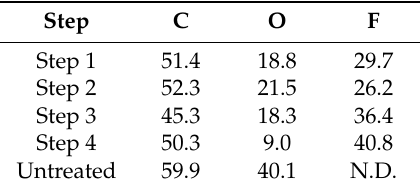
Table 5. XPS spectra analysis of fluorine bonding ratio (%).